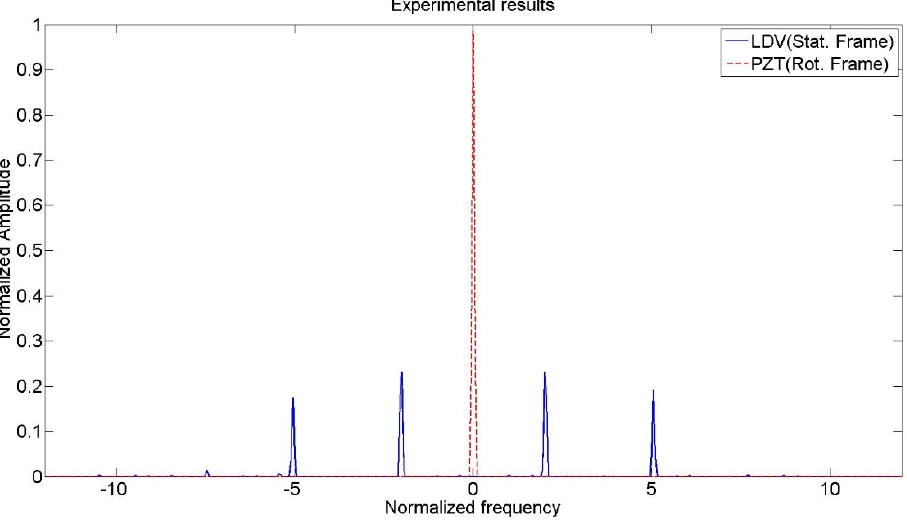
Figure 15. Normalized response of the PZT and LDV for the third mode in Figure 11.